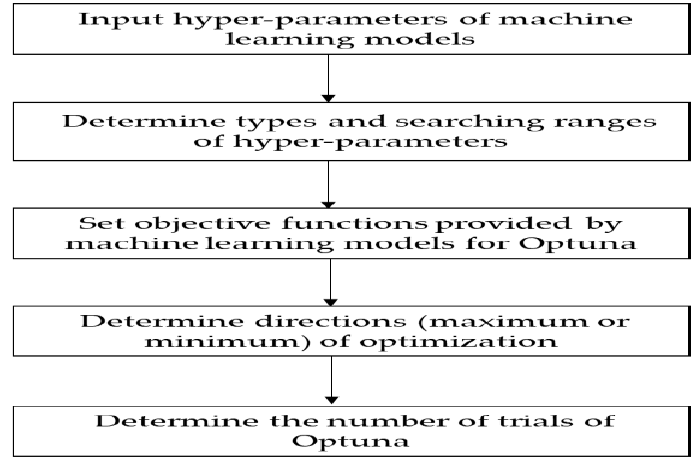
Figure 4. The basic Optuna procedure for hyperparameters selection.